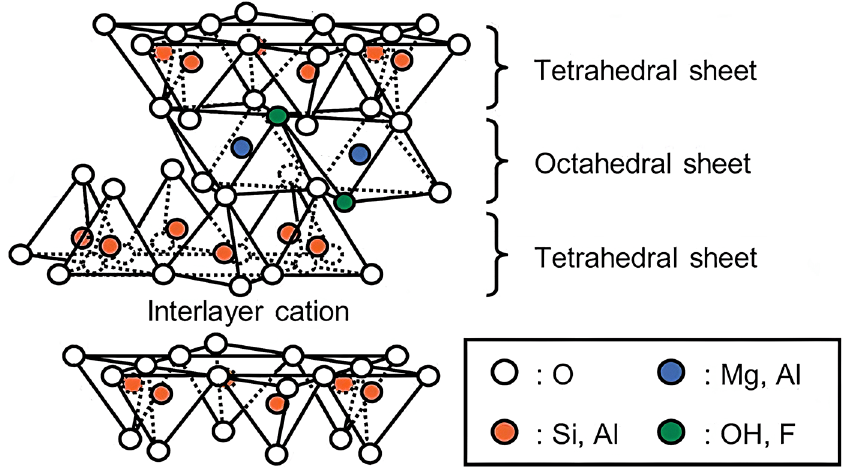
Figure 7. Structure of 2:1 layered silicates. Reprinted from Ref. [66], copyright 2014, with permission from Elsevier.